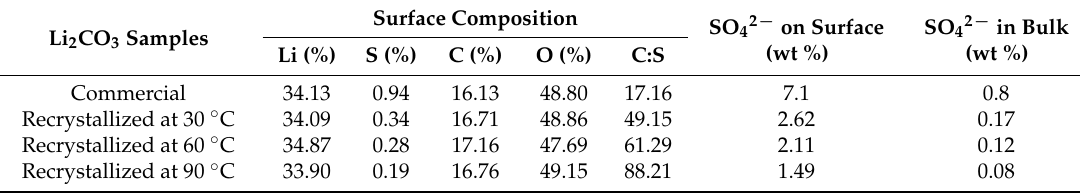
Table 1. Composition of Li 2 CO 3 on surface and in bulk.